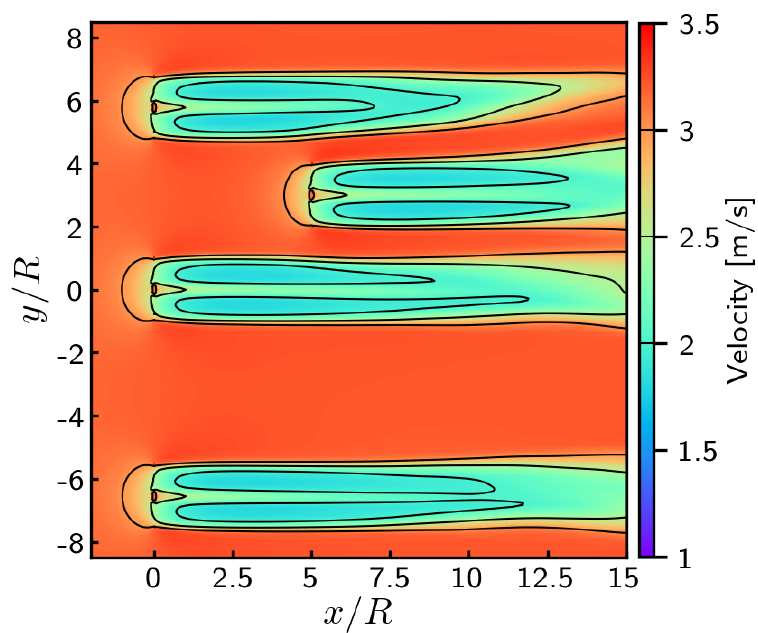
Figure 11. Time-averaged wakes obtained without ambient turbulence for TSR =